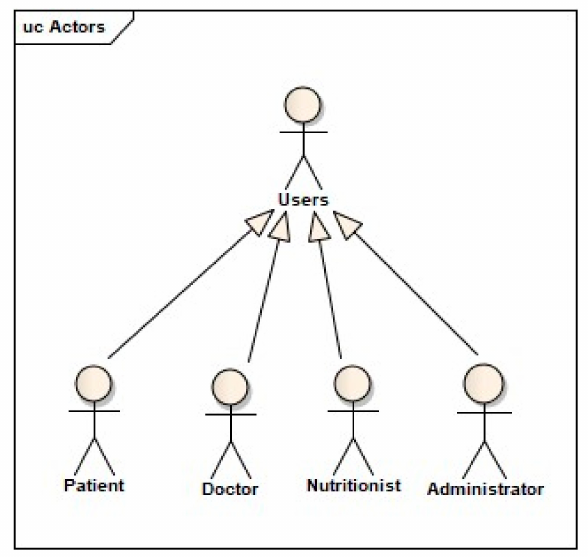
Figure 2. Telemonitoring system